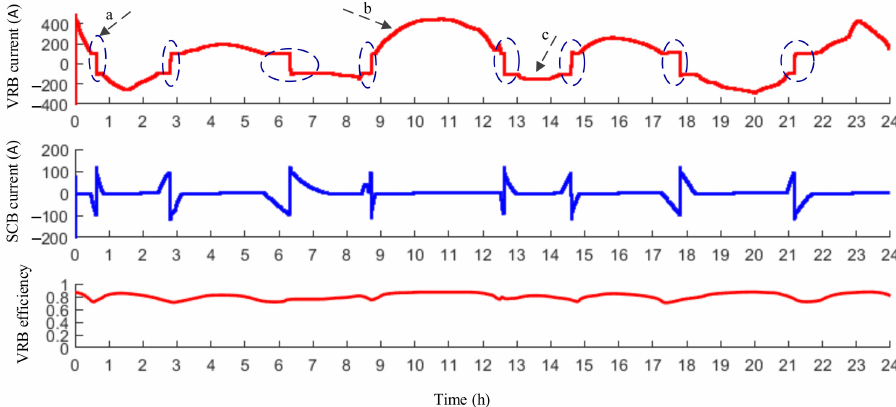
Figure 15. Current flow of HESS and operational efficiency of VRB over 24 h based on rule-based control